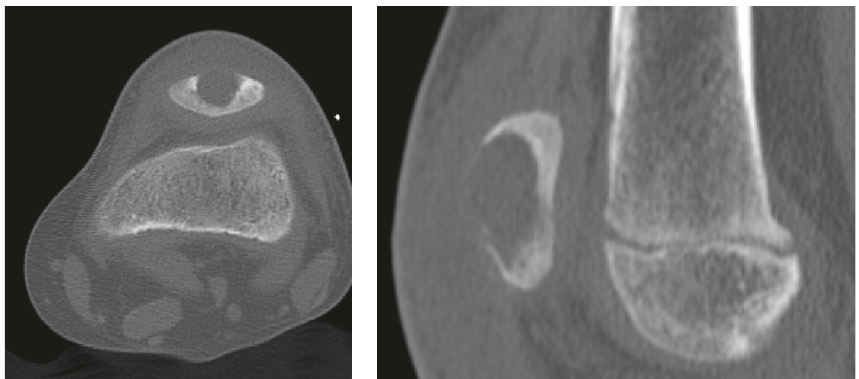
Figure 3: CT of the left knee clearly showing an osteolytic process with sharp borders.